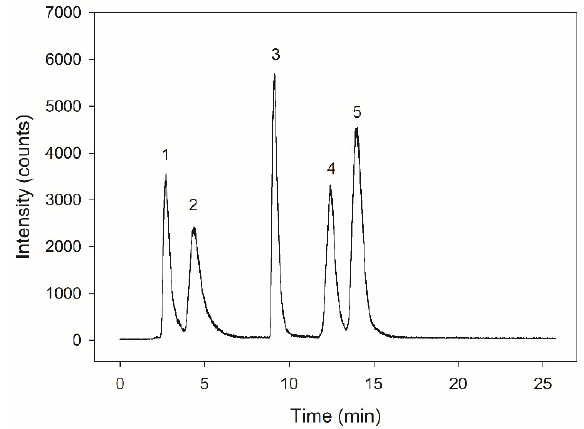
Figure 1. Chromatogram obtained for a standard mixture with 500 ppb concentration Se: 1: methyl‐ Se‐cysteine, t R = 2.6 min, 2: Se‐methionine, t R = 4.2 min, 3 : Se(IV), t R = 7.1 min, 4 : glutamyl‐Se‐ methylcysteine, t R = 11.3 min, 5 : Se(VI), t R = 13.3 min.